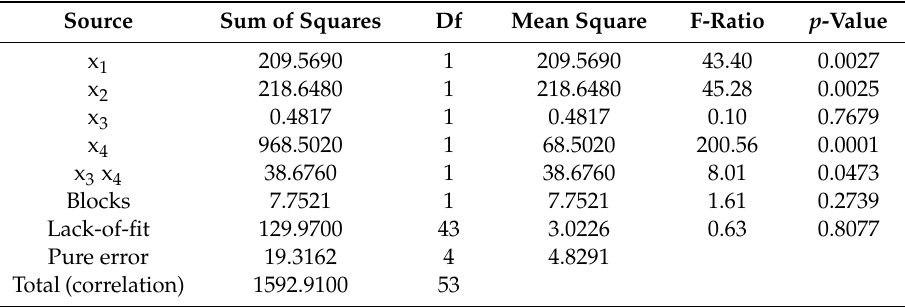
Table 5. Analysis of variance: the empirical model for predicting amyl alcohols.